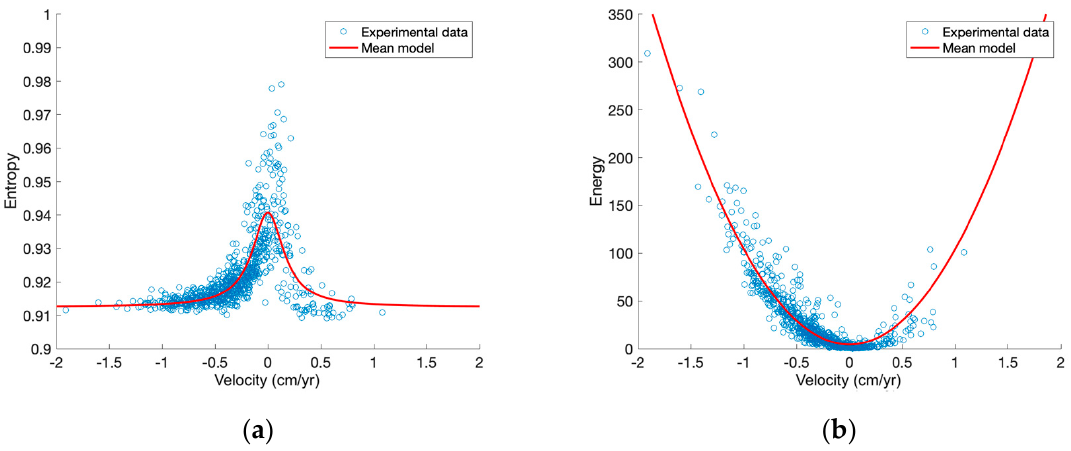
Figure 12. Correlation between LOS velocity and entropy–energy dispersion in the period from 2015 to 2019 for a building complex near San Giovanni station: ( a ) Entropy–velocity dispersion; ( b ) Energy–velocity dispersion.